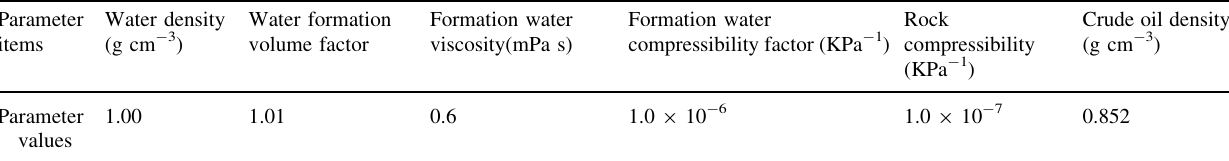
Table 2 The physical properties of reservoir and fluid in the model Parameter items